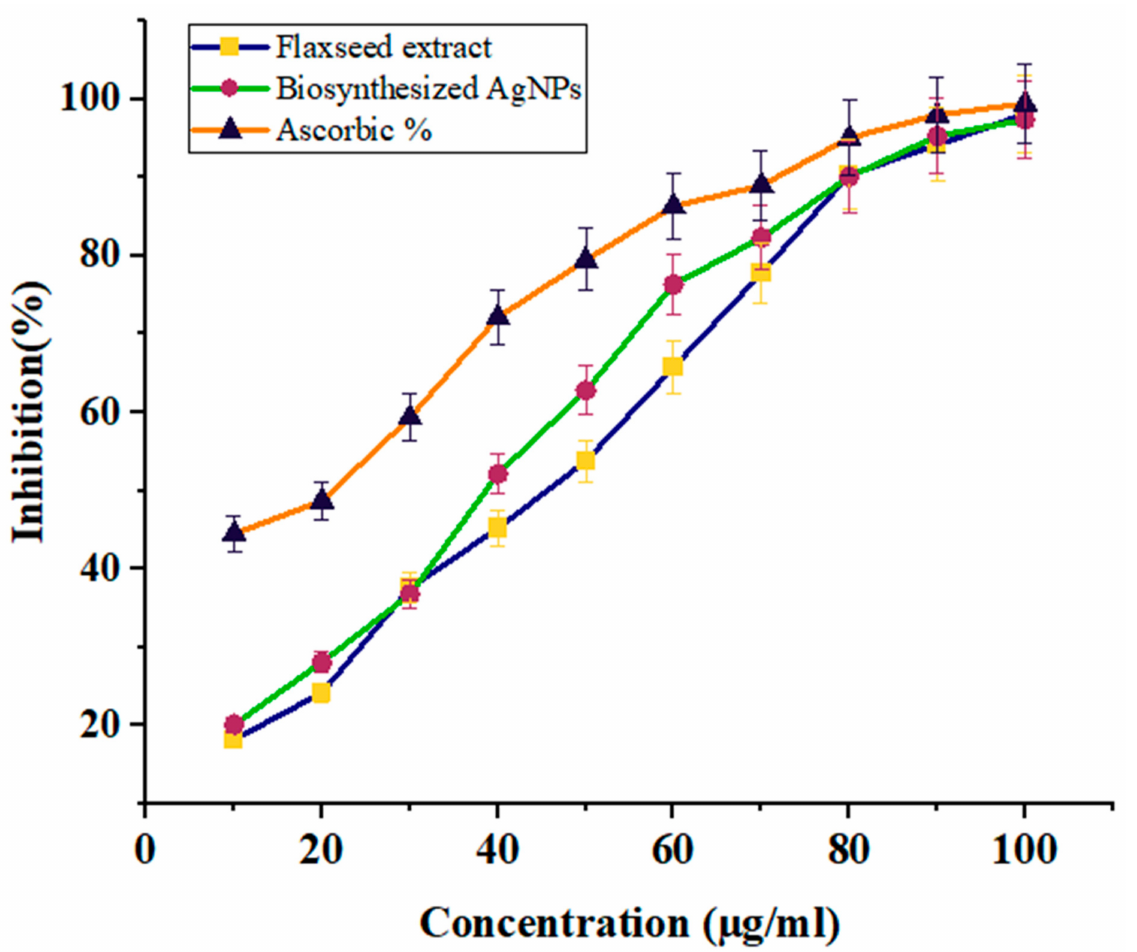
Figure 6. The graph represents the percentage of Antioxidant (DPPH) scavenging activity of green synthesized silver nanoparticles and flaxseed ethanolic